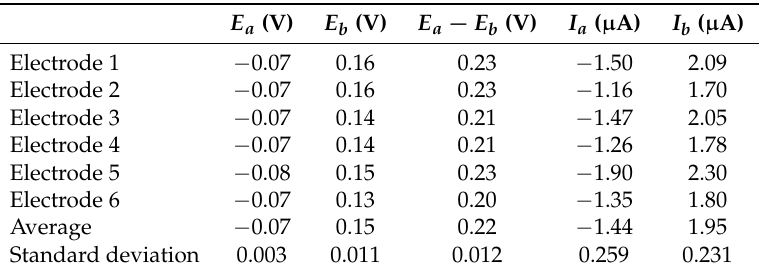
Table B1. Electrode Array